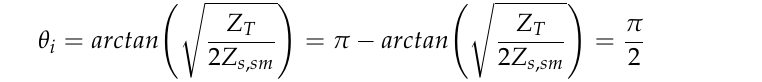
Table 2. Calculated electrical parameters for the proposed BPF.